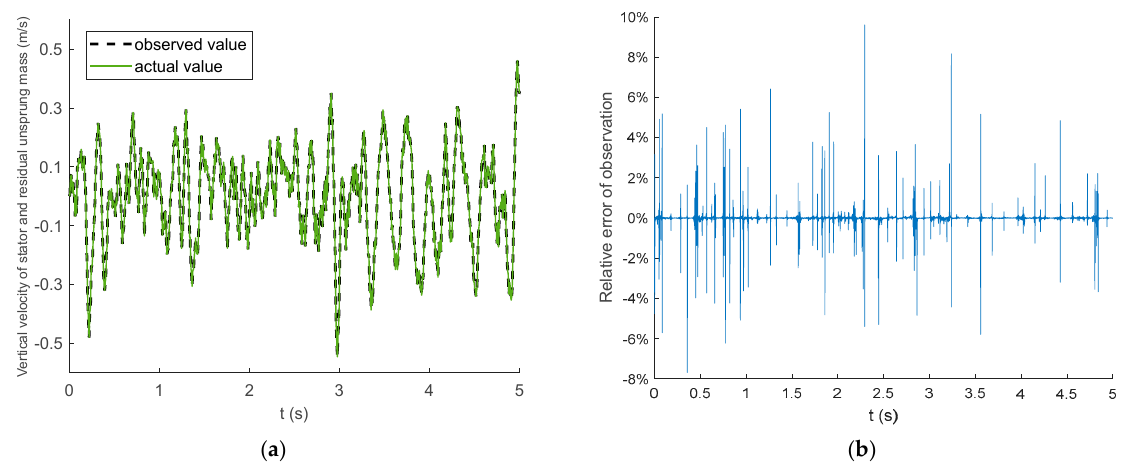
Figure 12. Observed results of vertical velocity of the sprung mass. ( a ) Comparison of observed and actual values. ( b ) Relative error between observed and actual values.